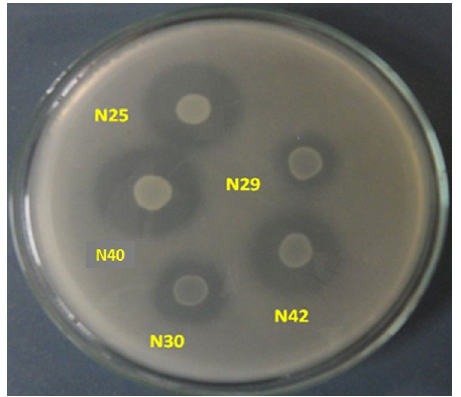
Fig. 4. Phosphate solubilization by some R. leguminosarum bv. viciae strains indicated by clear zone formation on nutrient agar plate containing tricalcium